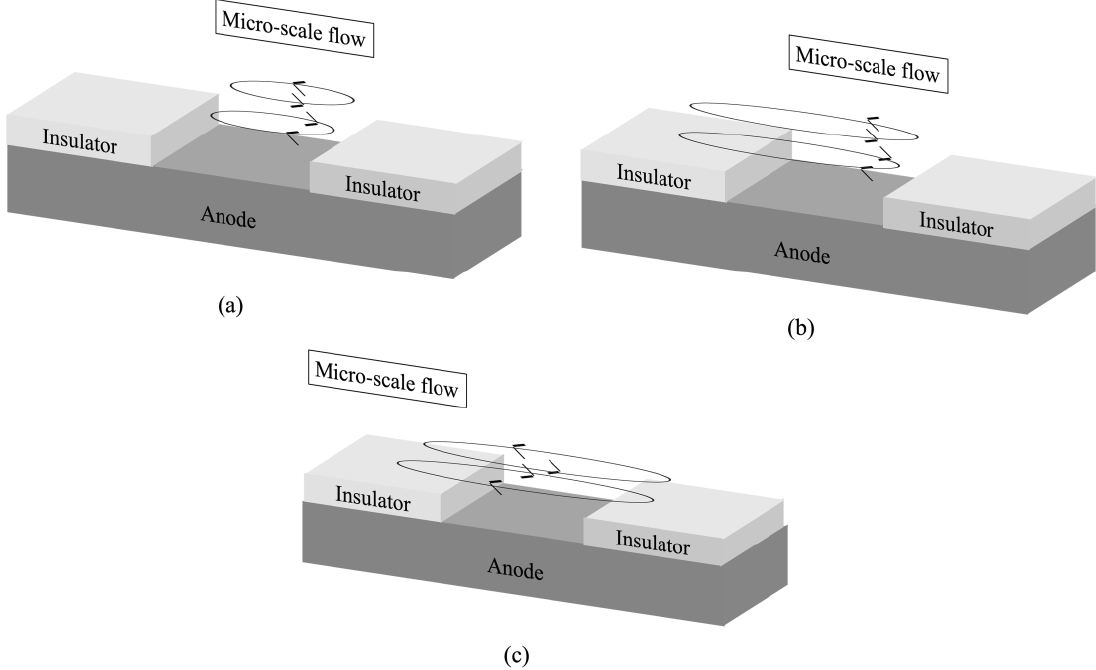
Figure 6. Liquid flow pattern under 2 Hz, 30 mA and 6 Hz, 30 mA conditions ( a ) at initial stage, and ( b ) and ( c ) with time development in the y -range of 120 µ m to 280 µ m. The liquid flow pattern under the 2 Hz, 50 mA condition was different from those under the DC + MF condition, the 2 Hz, 30 mA condition, and the 6 Hz, 30 mA condition, surface but also above the left and right sides’ insulators from the initial stage. The largest flow region under the 2 Hz, 50 mA condition corresponds to its largest maximum velocity among all the experimental conditions with the uniform magnetic field imposition, as shown in Figure 4.